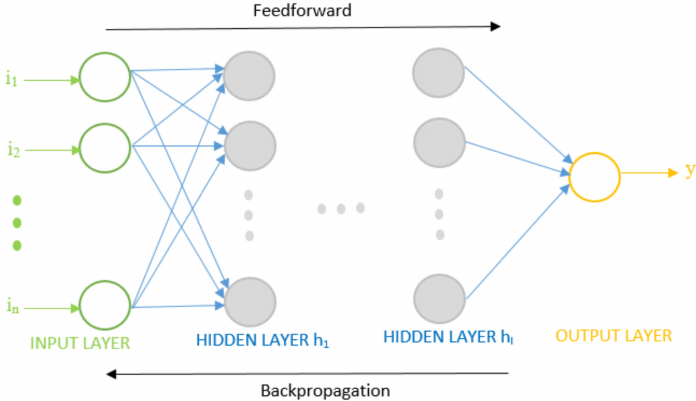
Figure 2. System model of multilayer feedforward neural